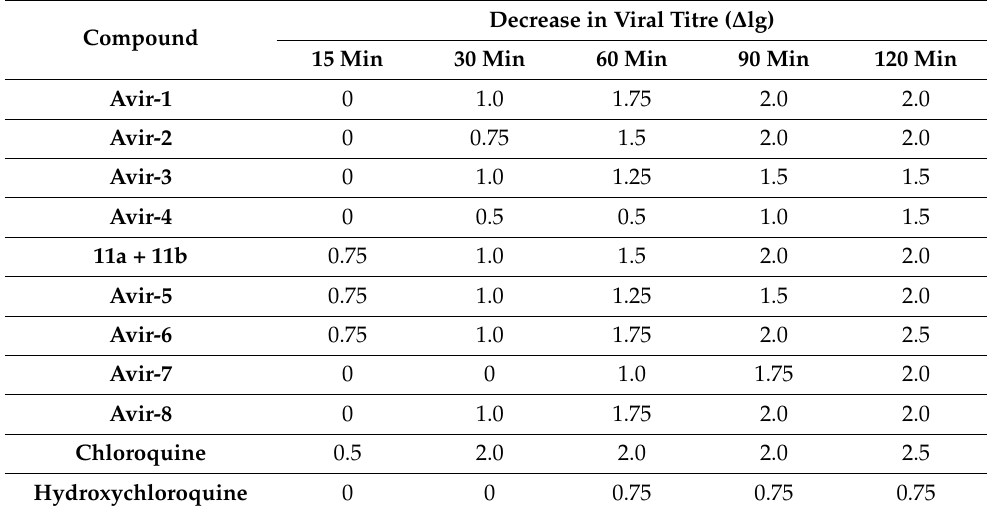
Table 6. Effect of heterocyclic compounds on the adsorption of coronavirus strain 229E on susceptible MRC-5 cells.